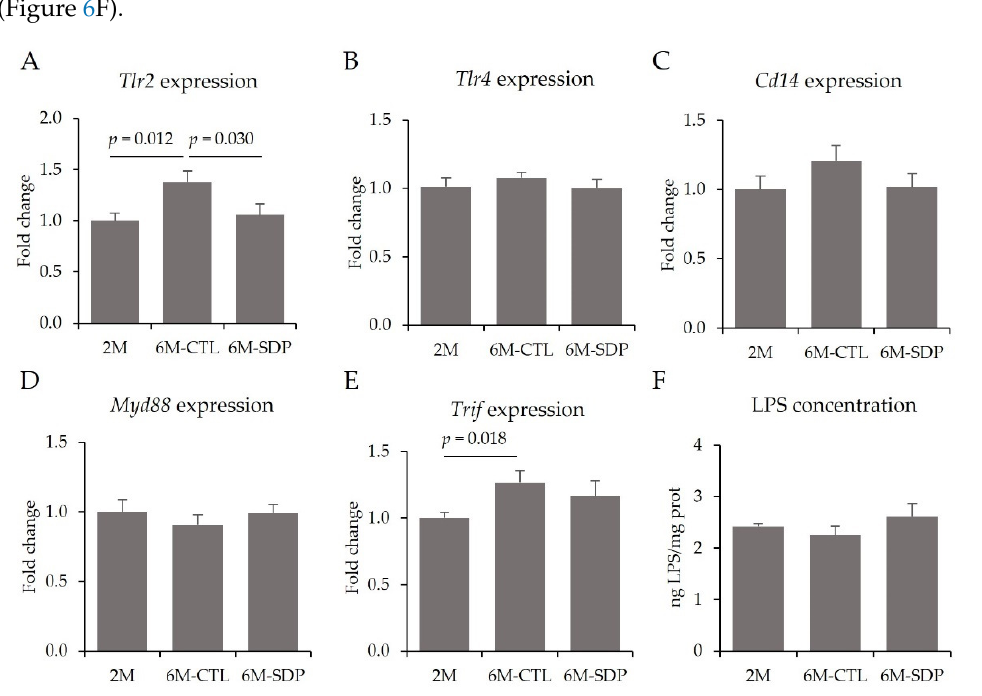
Figure 6. TLR signaling pathway in cortical tissue. Gene expression of Tlr2 ( A ), Tlr4 ( B ), Cd14 ( C ), Myd88 ( D ), Trif ( E ), and concentration of LPS ( F ). Results are expressed as mean ± SEM ( n = 6–9 mice/group). Statistics: ANOVA (Fisher multiple comparison test). Cd14, cluster of differentiation 14; LPS, lipopolysaccharide; Myd88, myeloid differentiation factor 88; Tlr, toll-like receptor; Trif, toll-like receptor adaptor molecule 1.